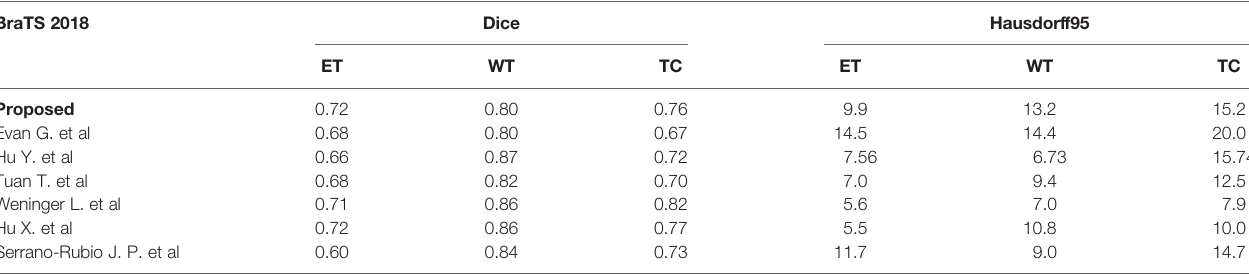
TABLE 3 | Comparison with the BraTS 2018 validation set of other methods. BraTS 2018